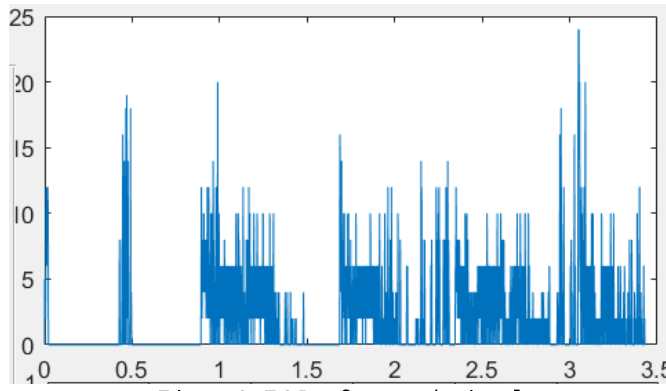
Figure 3. ZCR of a speech